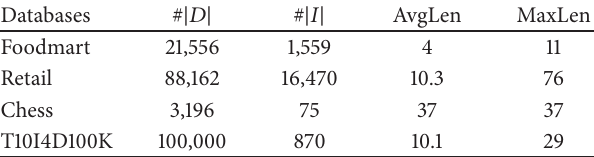
Table 7: Characteristics of used